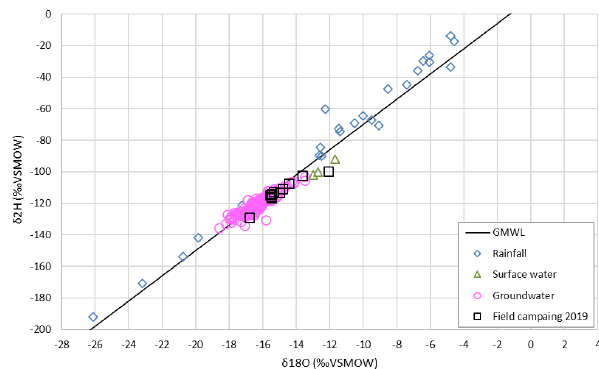
Figure 4. Isotopic values of the water: rainfall, surface water, groundwater samples compiled and groundwater samples from the field campaign performed during 2019. Most of these samples align with SMOW